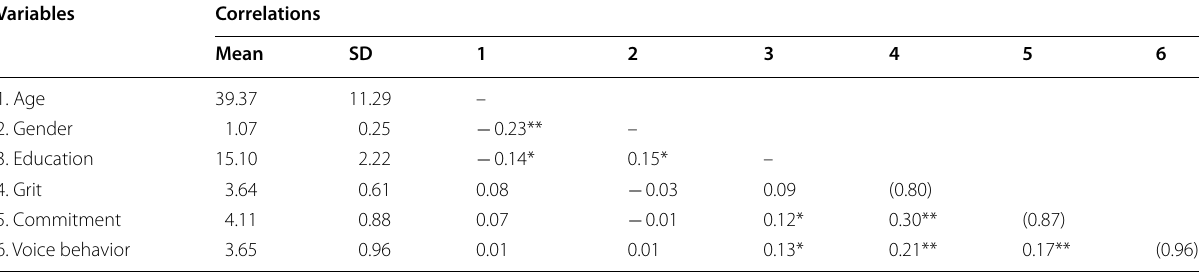
Table 1 Descriptive statistics and correlation matrix